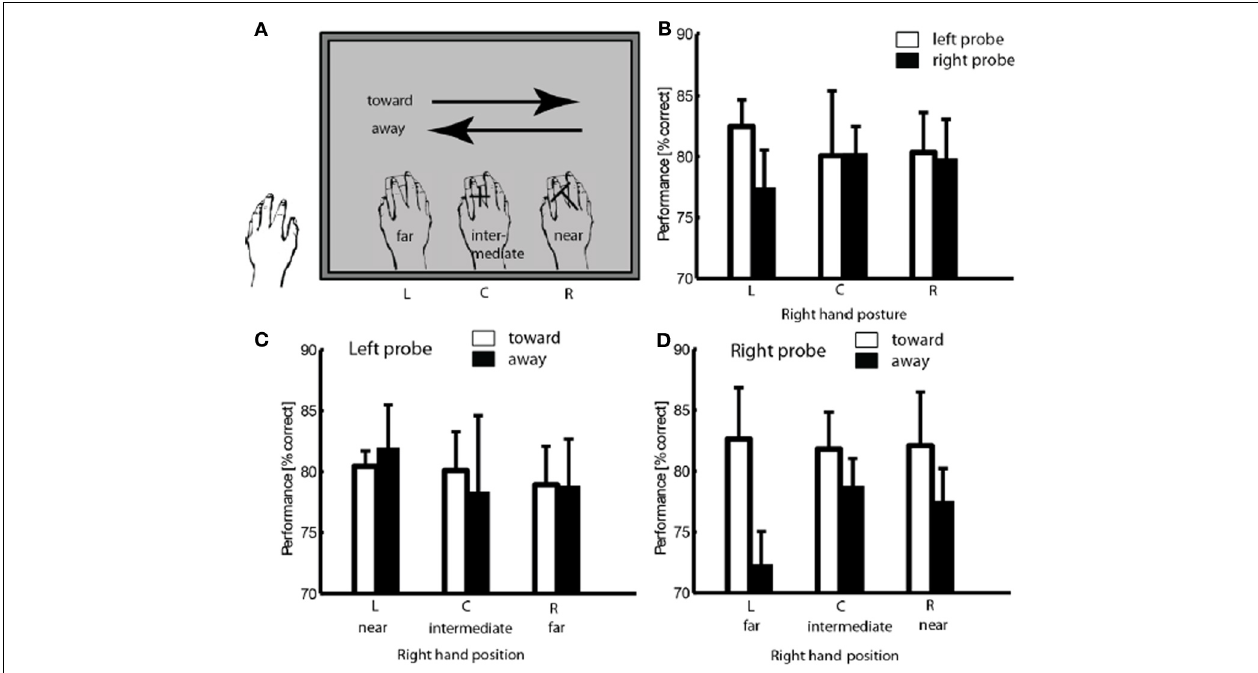
FIGURE 3 | Illustration of trial classification, using a trial with probe at position R as example (A). Performance in different hand positions for two probe locations. (B) Performance in discrimination left and right probe as a function of hand position and movement direction (C,D) Error bars show standard error of the